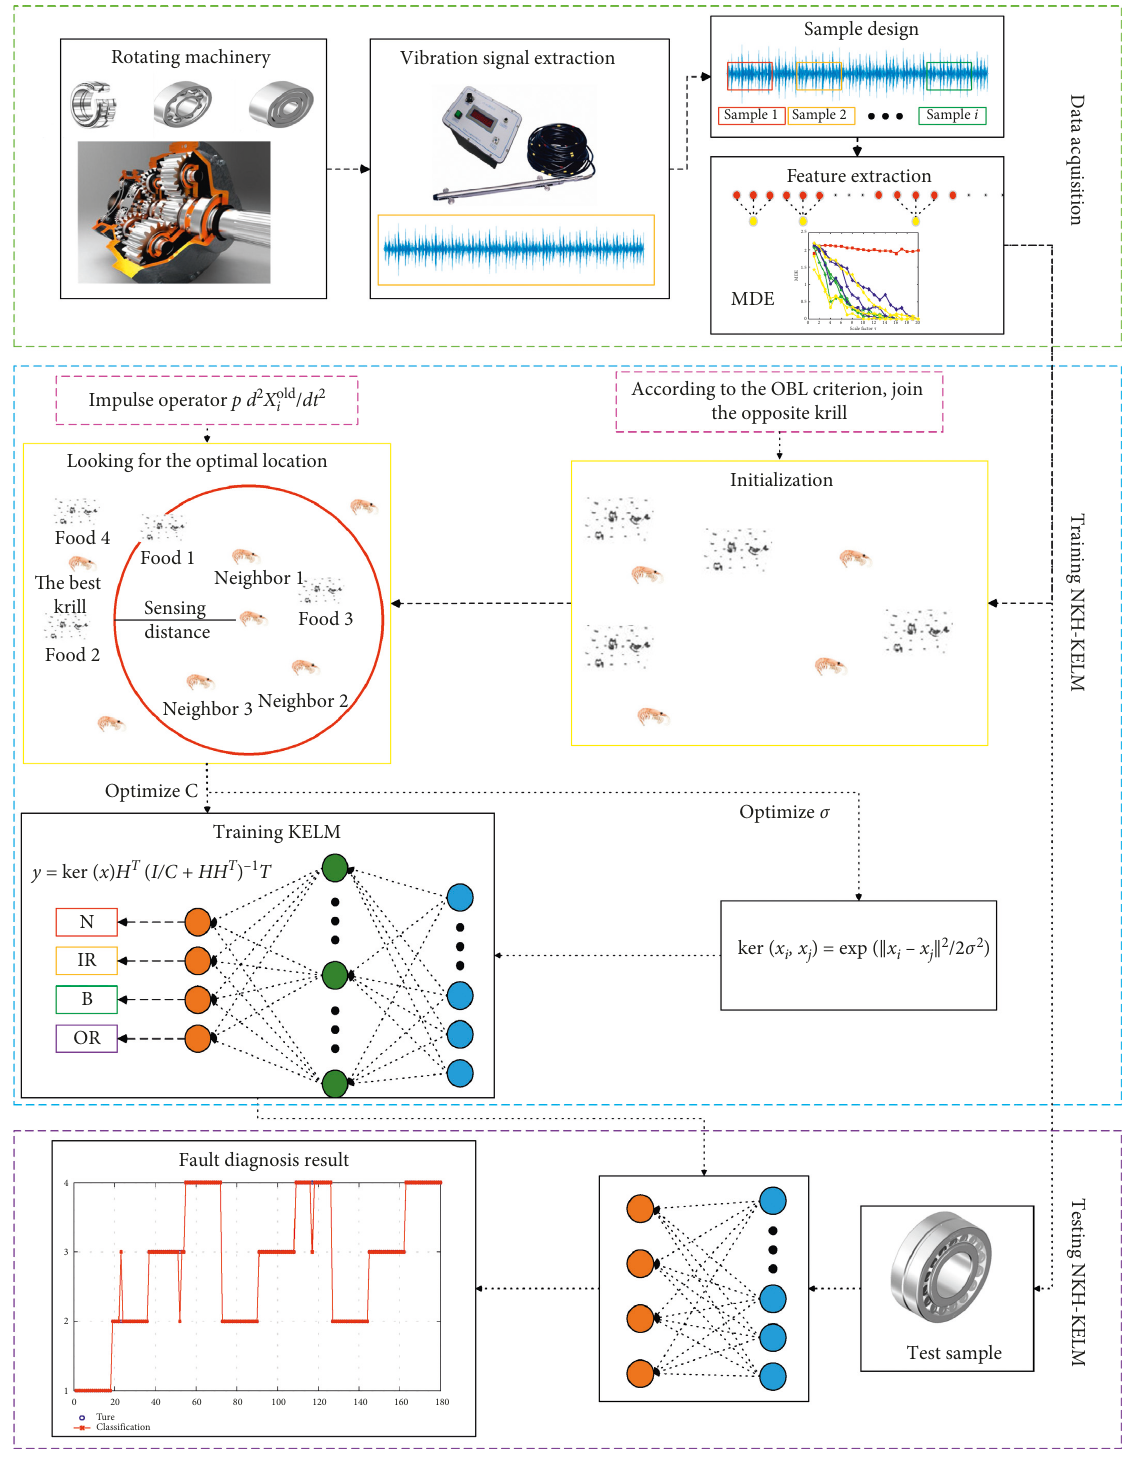
Figure 6: Flow chart of